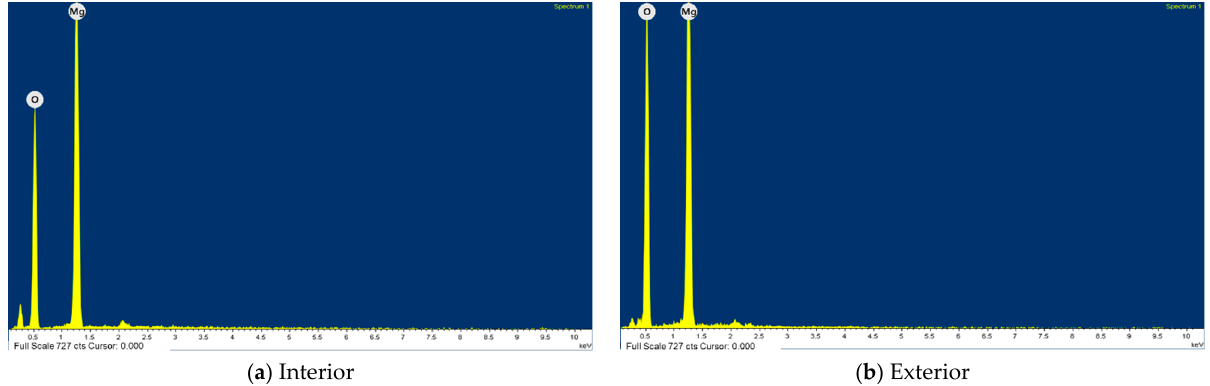
Figure 17. Electron images and spectra graphs of magnesium combustion’s by-products from the interior ( a ) and exterior ( b ). Table 3. Rate of the interior and exterior by-product of magnesium.